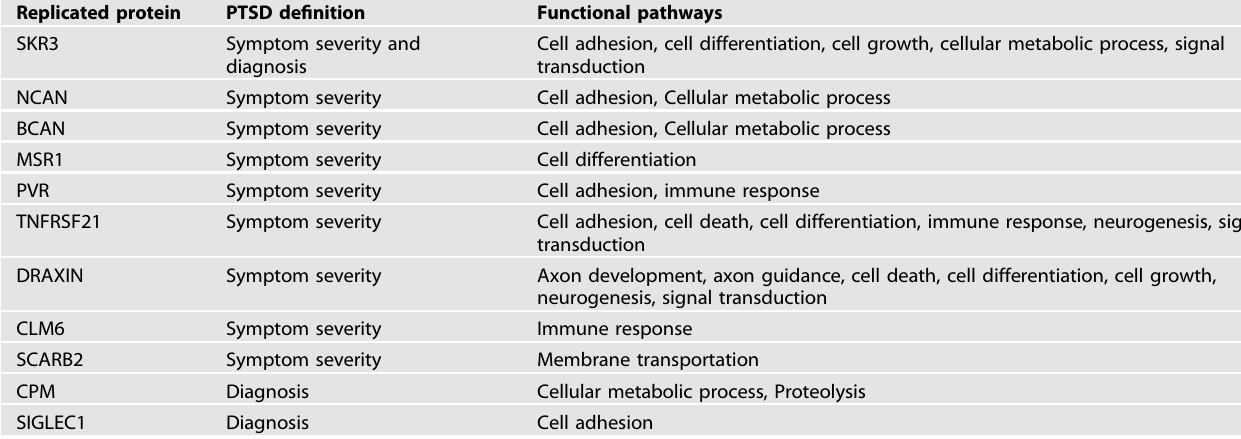
Table 3. Functional pathways of 11 replicated proteins associated with PTSD.